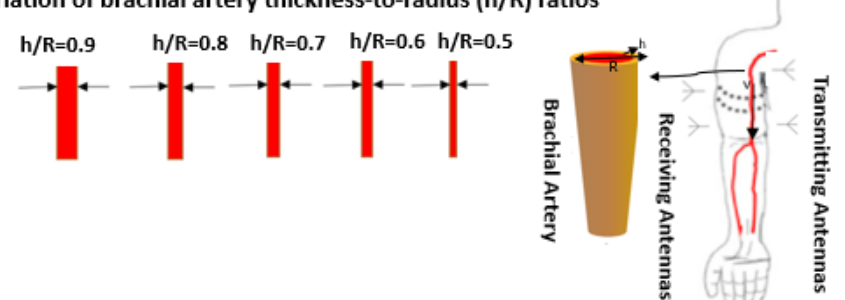
Figure 9. Illustration of proposed method related to brachial artery h/R ratio variation in respect to blood pressure estimation. Healthy elastic arteries = Normal BP and elastic artery stiffening = increase CV risk. The arterial vessel is often modeled as an elastic cylindrical tube. The simulation would be performed at five instances of brachial artery diameters to mimic the condition of blood flow. Al- though the above simulation model lacks blood flow, the consideration of different arterial diameters partly compensates for the hemodynamic effects. The choice of different arterial diameters complies with the characteristics of the arterial system. It was reasonably assumed that the brachial artery diameter changes uniformly at each dielectric characteristic change of the flow of blood, fat, muscle, bone and skin.